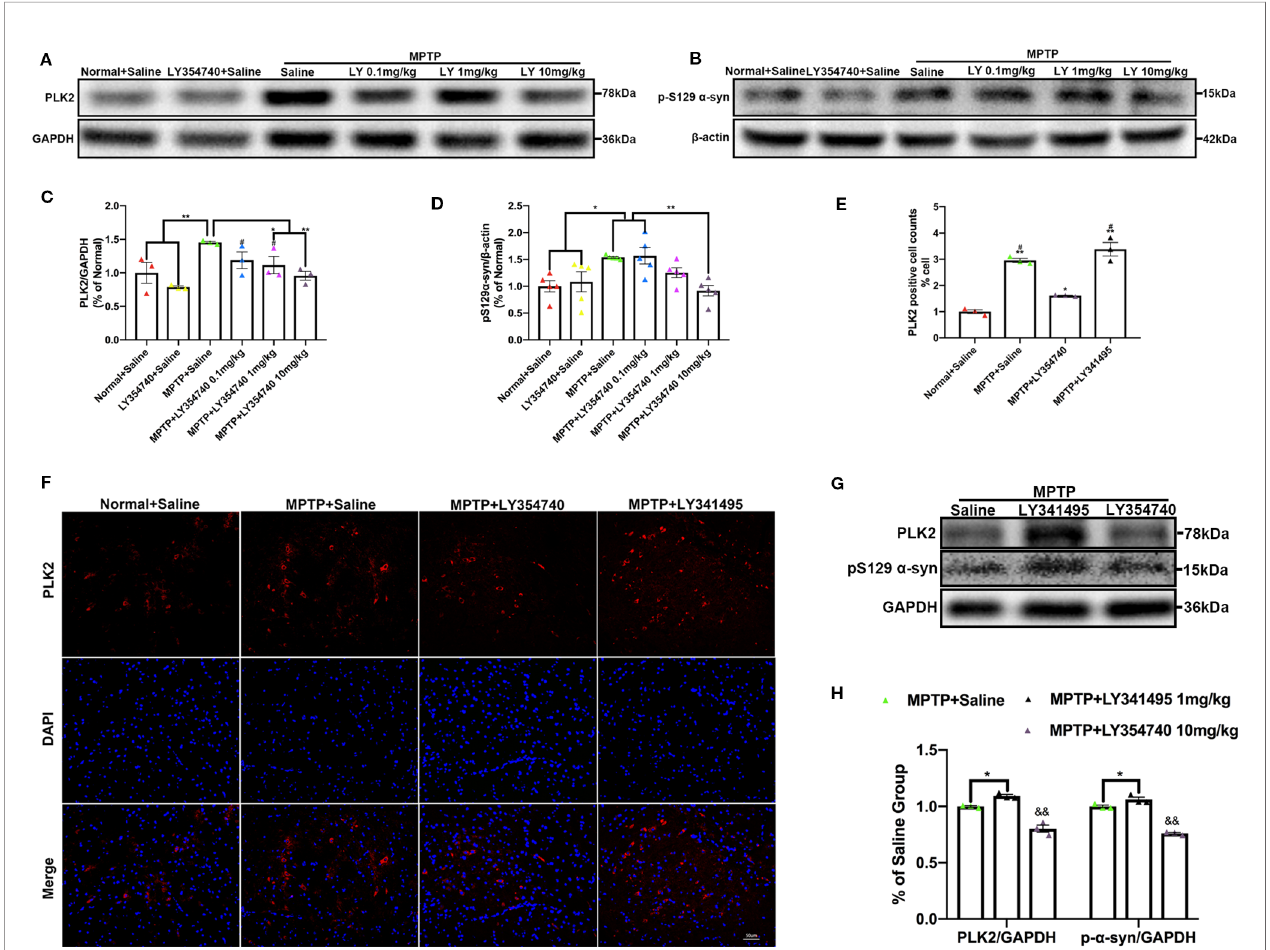
FIGURE 5 | Ligands of mGlu 2/3 receptors regulate expression of polo-like kinase 2 (PLK2) and phosphorylated a -synuclein at Ser129 in substantia nigra (SN) of sub-acute 1-methyl-4-phenyl-1,2,3,6-tetrahydropyridine (MPTP)-induced Parkinson ’ s disease (PD) mice model. Western blots represent the expression of PLK2 (A) and pS129 a -synuclein (B) in SN of each group. The band intensity of particular target proteins was normalized to glyceraldehyde 3-phosphate dehydrogenase (GAPDH) or b -actin level (C, D) . * p < 0.05, ** p < 0.01; # p < 0.05 vs. LY354740 + saline group. N = 3 in (C) ; N = 4 in (D) . Data were expressed as % of the normal + saline group and shown as the mean ± SEM. Immunoblots (G) and corresponding histograms (H) show expression of PLK2 and pS129 a -synuclein in SN. && p < 0.01 compared with other two groups; * p < 0.05. N = 3. Data were expressed as % of the MPTP + saline group and shown as the mean ± SEM. (E, F) Immuno fl uorescence and analysis of PLK2 positive cell counts in SN. Scale bar = 50 µm. * p < 0.05, ** p < 0.01 compared with Normal+Saline group; # p < 0.05 compared with MPTP+LY354740 group. N = 3. Data were shown as the mean ±